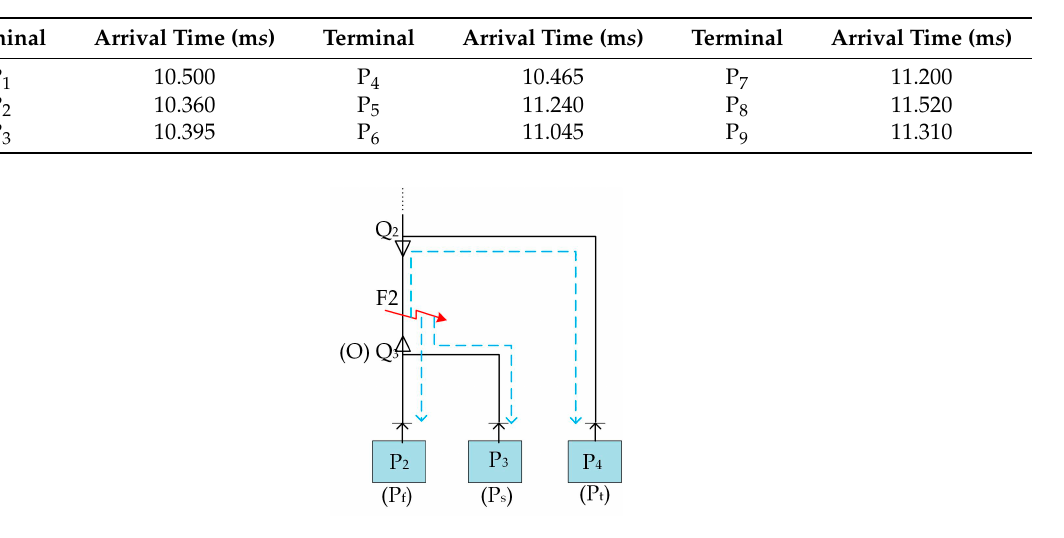
Figure 11. Identified three-terminal fault section for fault F2.